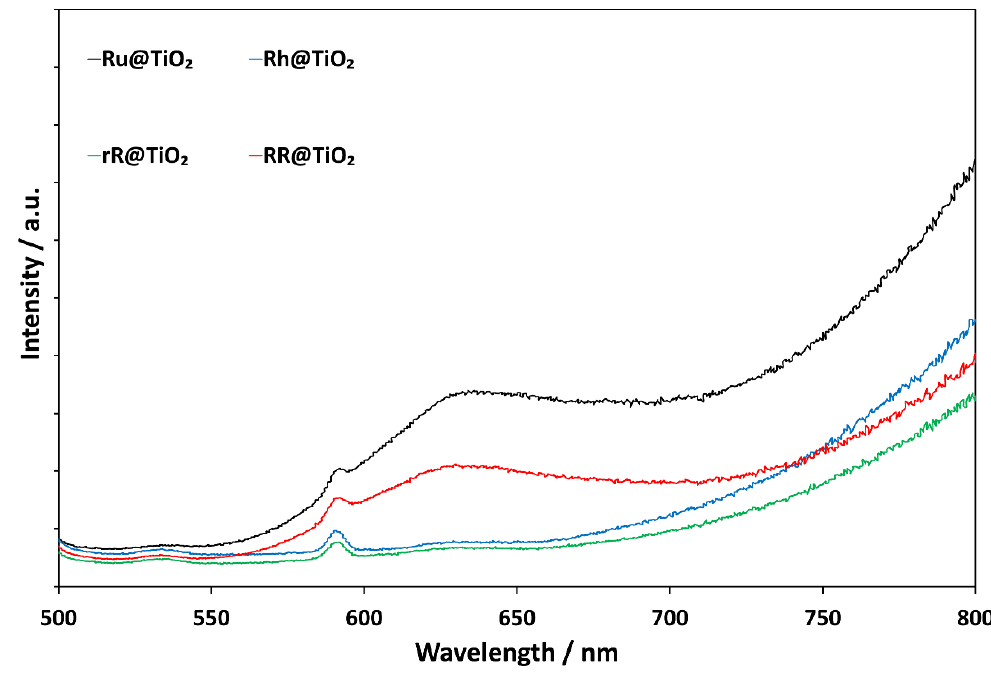
Figure 1. Emission spectra of complex-functionalized NPs after excitation at 450 nm. Excitation slit width 3 nm, emission slit width 10 nm.